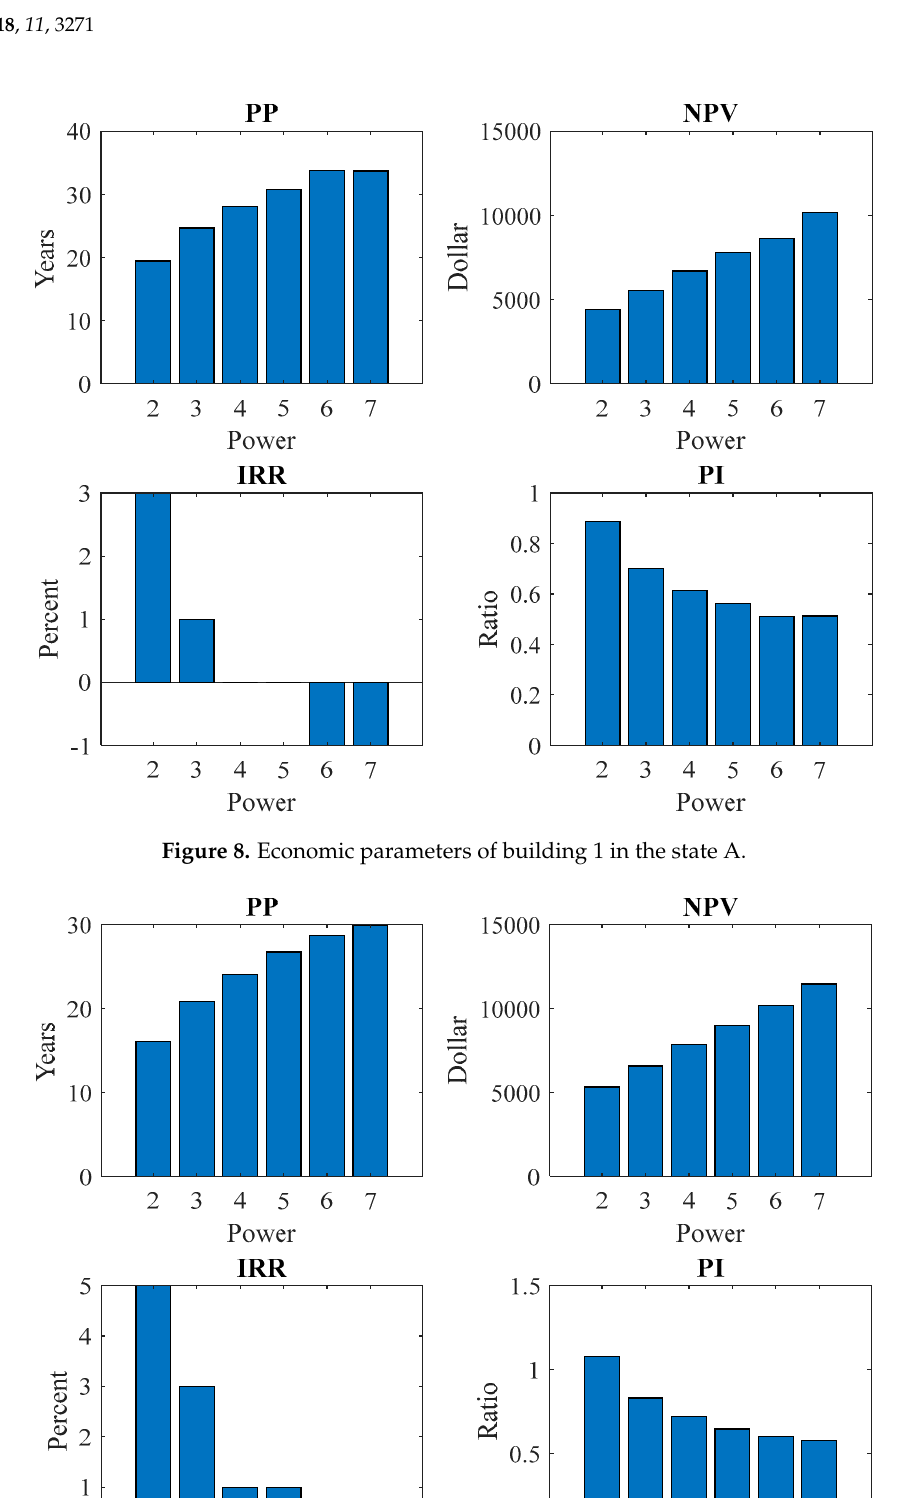
Figure 10. Economic parameters of building 3 in the state A.